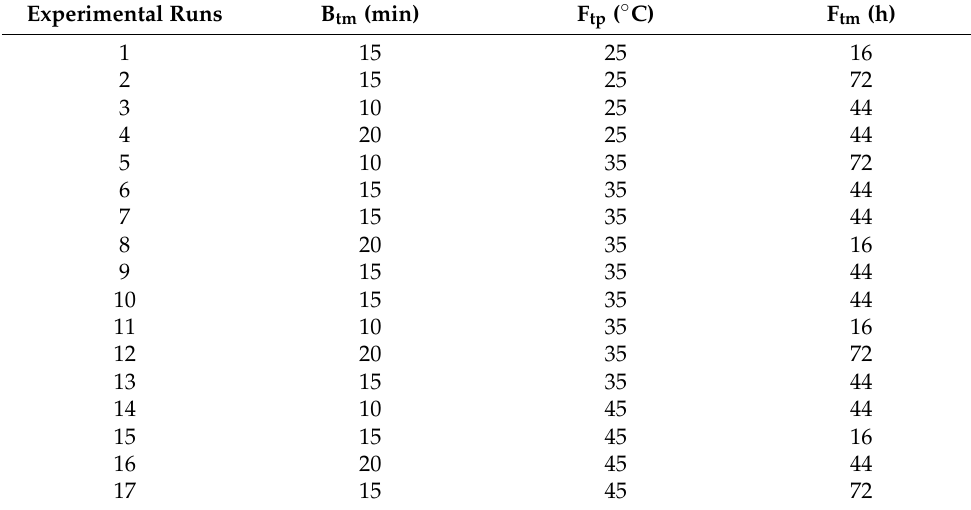
Table 1. Statistical experimental design of independent variables for mahewu production using the Box–Behnken design of response surface methodology. Experimental